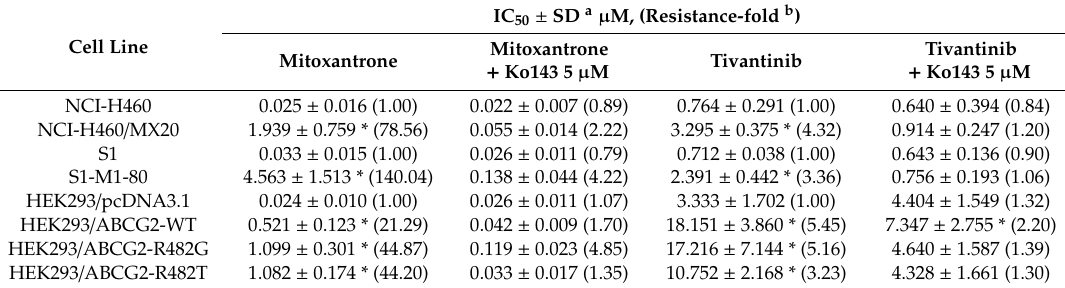
Figure 1. Chemical structure and cytotoxicity of tivantinib in parental and ATP-binding cassette super-family G member 2 (ABCG2)-overexpressing cells. ( A ) Chemical structure of tivantinib; ( B ) cell viability curves for NCI-H460 and NCI-H460 / MX20 cells; ( C ) cell viability curves for S1 and S1-M1-80 cells; ( D ) cell viability curves for HEK293 / pcDNA3.1, HEK293 / ABCG2-WT, HEK293 / ABCG2-R482G, and HEK293 / ABCG2-R482T cells. Data are expressed as the mean ± SD from a representative of three independent experiments. Table 1. The cytotoxicity of tivantinib in cells overexpressing ABCG2.